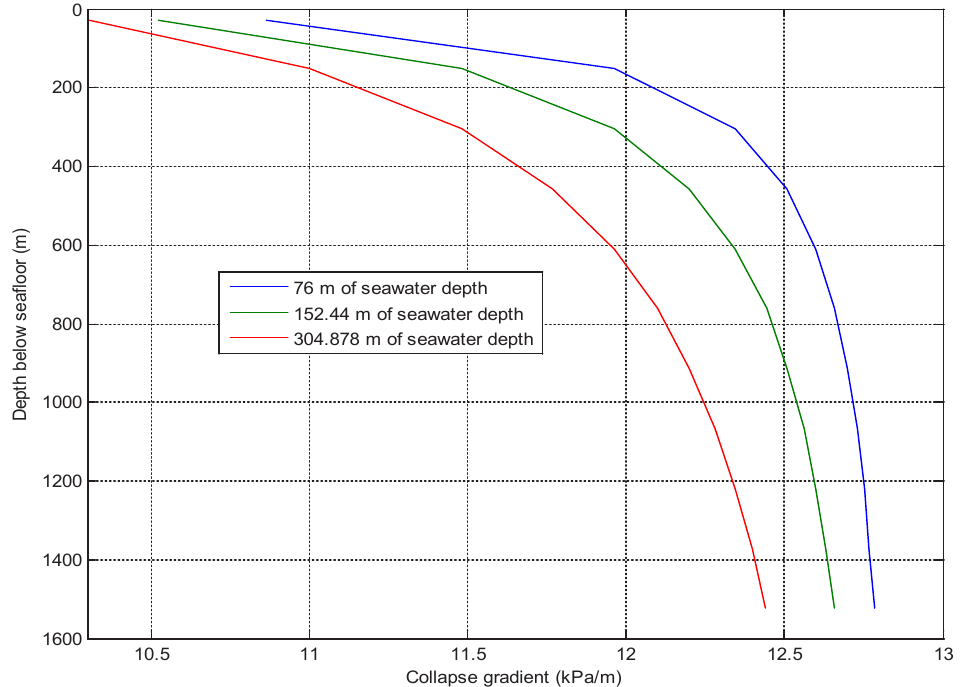
Figure 2 - Variation of wellbore collapse within the formation due to the column of